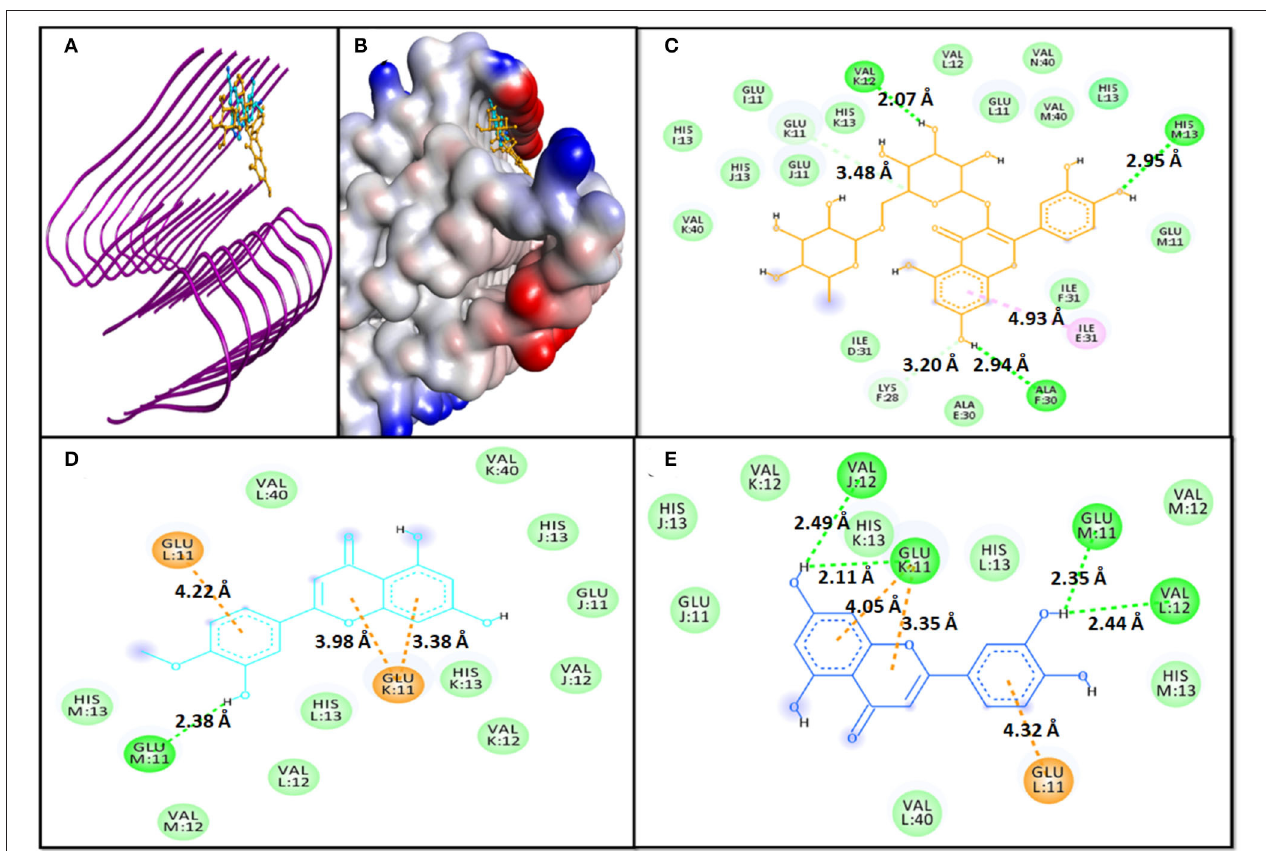
FIGURE 2 | Molecular docking of 6TI5 with phytochemicals. (A) 2D representation of the binding of phytochemical to 6TI5, (B) 3D representation of the binding of phytochemical to 6TI5, (C) Interaction between 6TI5 and Rutin, (D) Interaction between 6TI5 and Diosmetin, and (E) Interaction between 6TI5 and